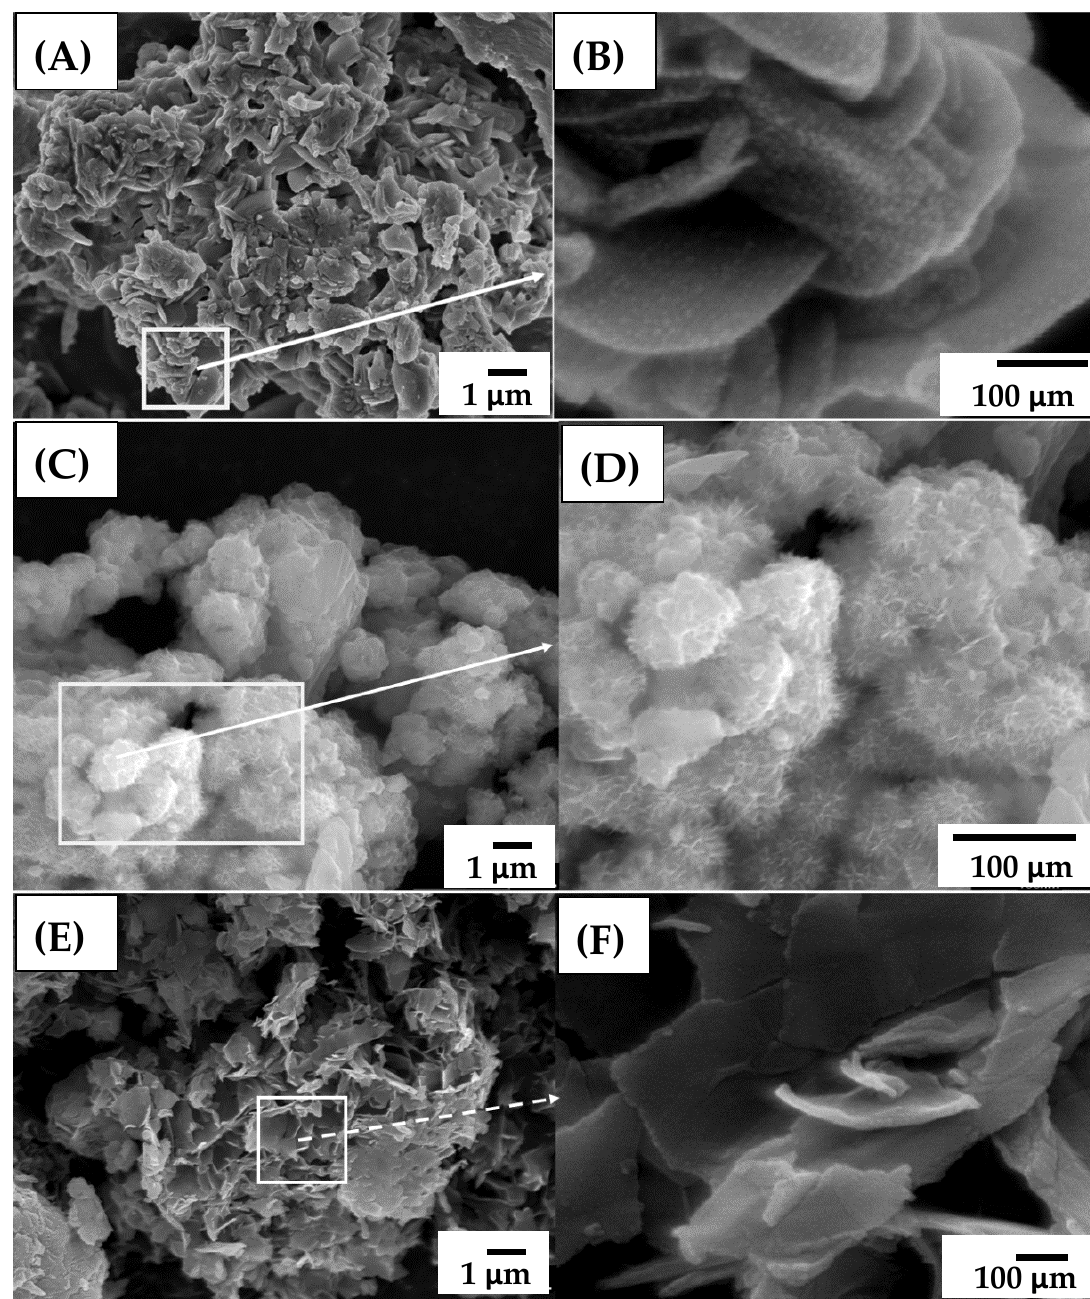
Figure 2. Scanning electron micrographs of ( A , B ) Ni50-Fe50 wt%, ( C , D ) Ni80-Fe20 wt%, and ( E , F ) Ni90-Fe10 wt% samples at two different scales and zones as indicated by arrows. All samples are the products obtained from the application of 20 kHz ultrasonic irradiation.